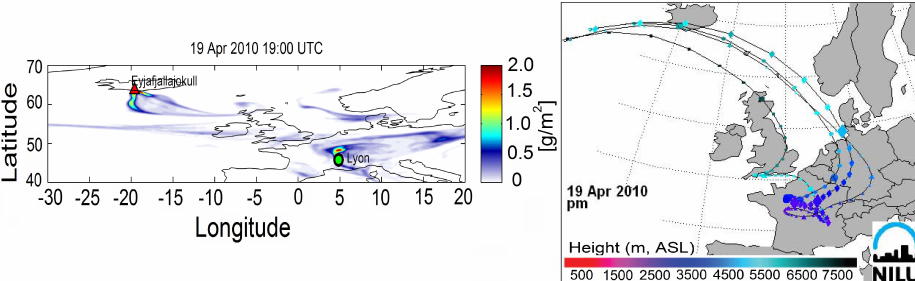
Fig. 6. Evidence of the presence of volcanic ash over Lyon on 19 April at 19:00UTC. Left: NILU FLEXPART ash particle numerical dispersion model for 19 April 2010 at 19:00UTC. Right: NILU FLEXTRA 7-day air mass back trajectories on 19 April at 18:00UTC (2km, triangles; 3km, circles; 5km altitude, squares) and at 12:00UTC (3km, diamonds).